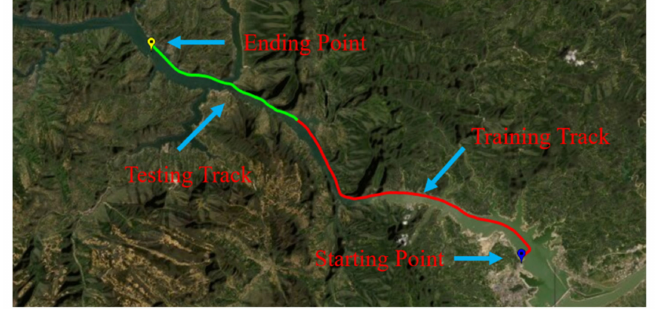
Figure 9. Division diagram of training track and test track.